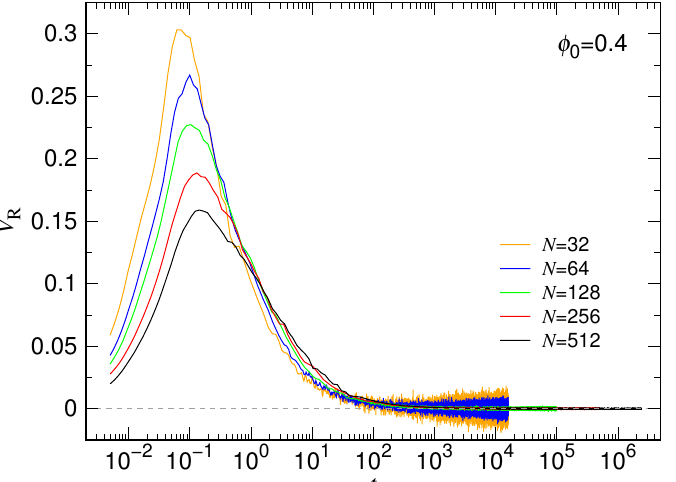
Figure 16. Expansion velocity V R as a function of time t for φ 0 = 0.4. The chain length N can be read in the